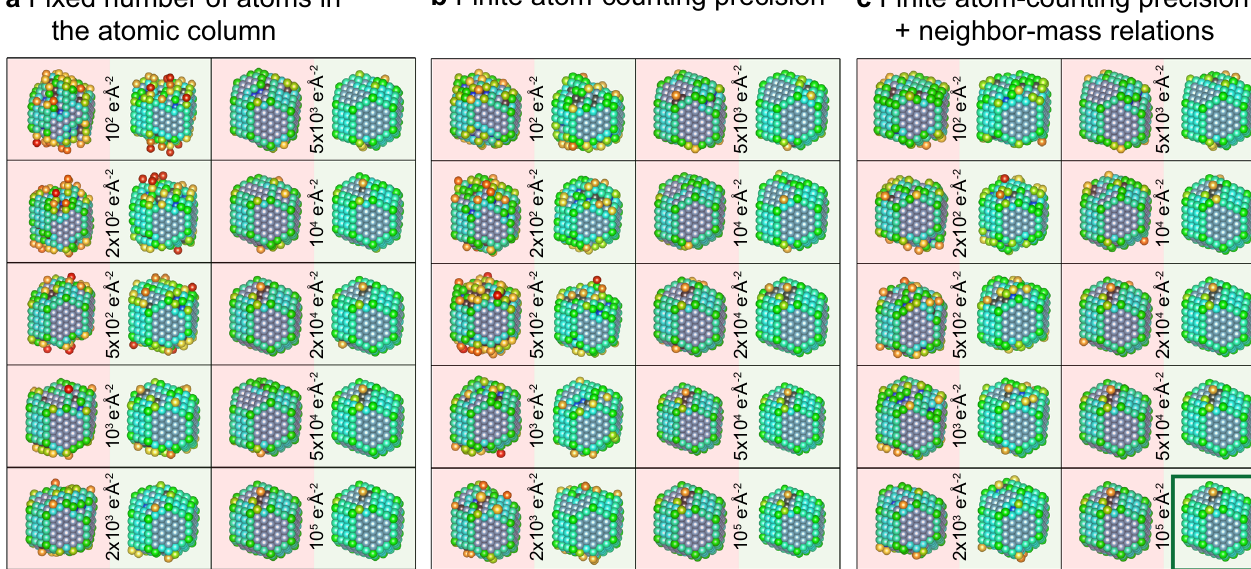
Fig. 4 Visualization of the reconstructed 3D atomic models. A lower bound (red background) and upper bound (green background) of an 80% prediction interval are represented for the reconstructions when using a a fi xed number of atoms in the atomic column during the reconstruction, b the fi nite atom-counting precision, and c the fi nite atom-counting precision and the neighbor-mass relations. The reconstruction in the box in the lower right corner corresponds to the ground truth model. The coloring of the atoms corresponds to the nearest-neighbor coordination, from 1 in red to 12 in dark blue.